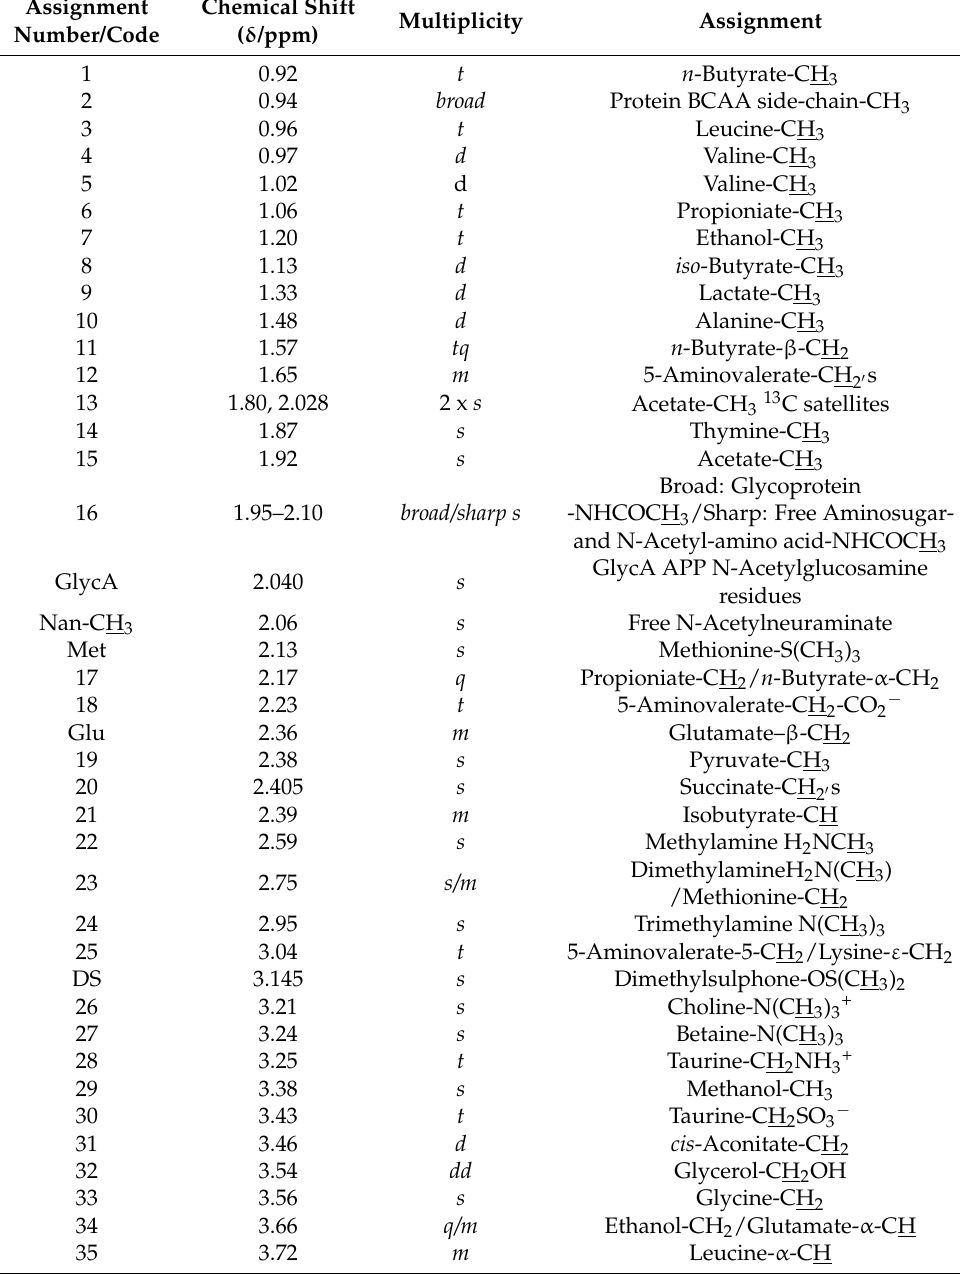
Table 1. 1 H NMR Resonance Assignments for Human WMSS Samples at an Operating Frequency of 600 MHz. * Broad resonance located at δ = 8.05 ppm, which along with those at ö = 6.85 and 7.55 ppm [1] (also visible in Figure 1b), presumably arise from salivary protein tyrosine, pheny- lalanine, tryptophan and/or histidine residues. ** This aldehydic proton (-CHO function) signal may be a singlet or a triplet; if a triplet, as in saturated aldehydes ( n -alkanals), without expansion it appears as a singlet in view of a very low J coupling constant value (1.4 Hz) [3]. Abbreviations: APP, acute-phase protein; s , d , t , q and m , singlet, doublet, triplet, quartet and multiplet resonance multiplicities,